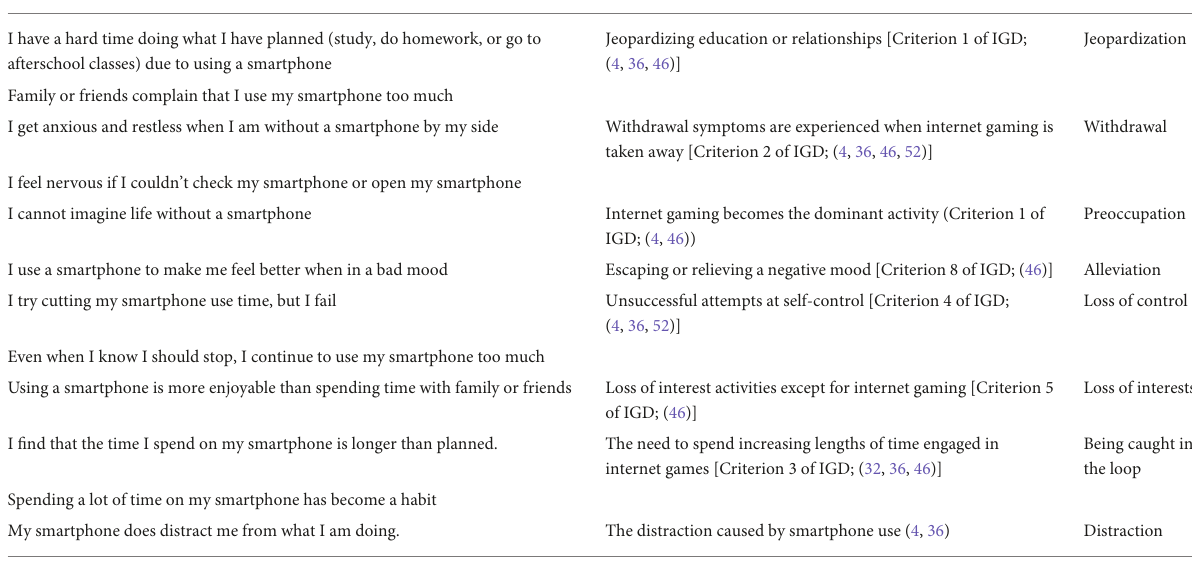
TABLE 2 Detailed information about PSU symptoms and related